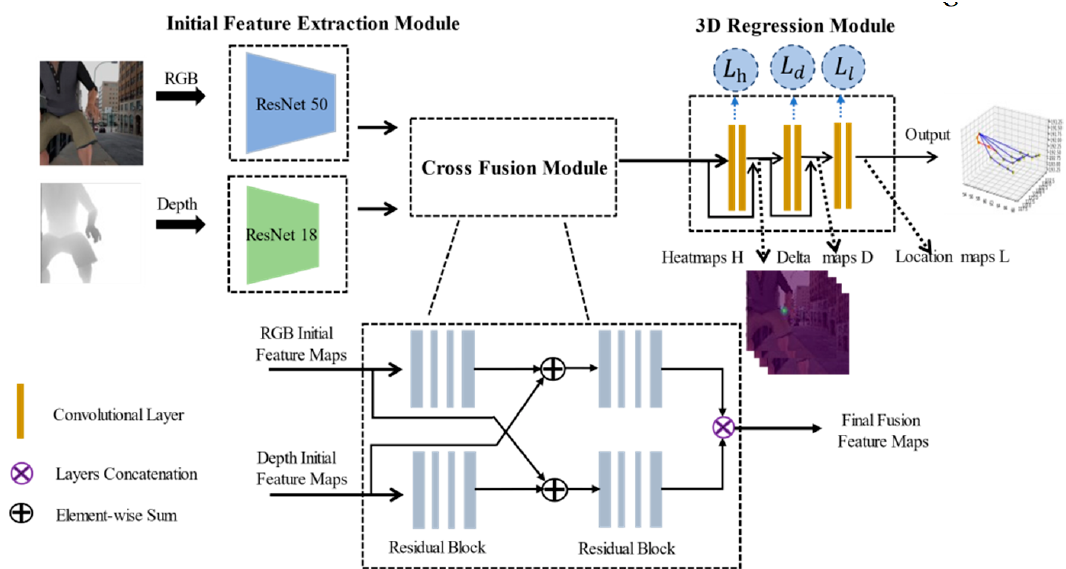
Figure 2. Overview of our architecture. It contains three modules: the initial feature extraction module, cross-fusion module, and 3D regression module . First, our initial feature extractor obtains initial RGB and depth feature maps from a pair of RGB images and depth maps. Second, the feature maps are fused in the cross-fusion module. Third, the regression module obtains both 2D and 3D hand-joints.